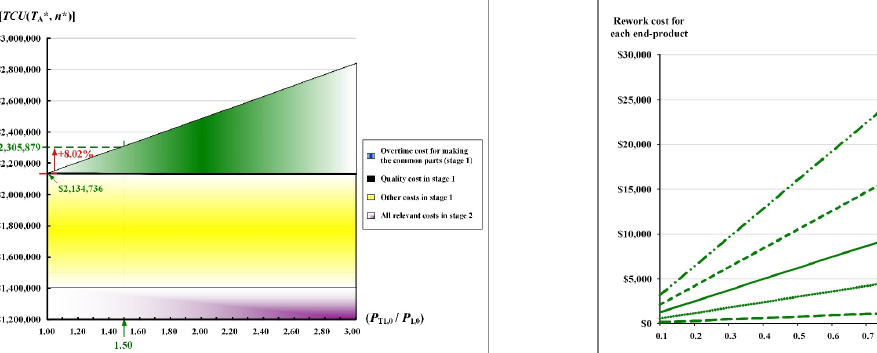
Fig. 16. The average ( C R, i / C i ) effect on the rework cost for each end product